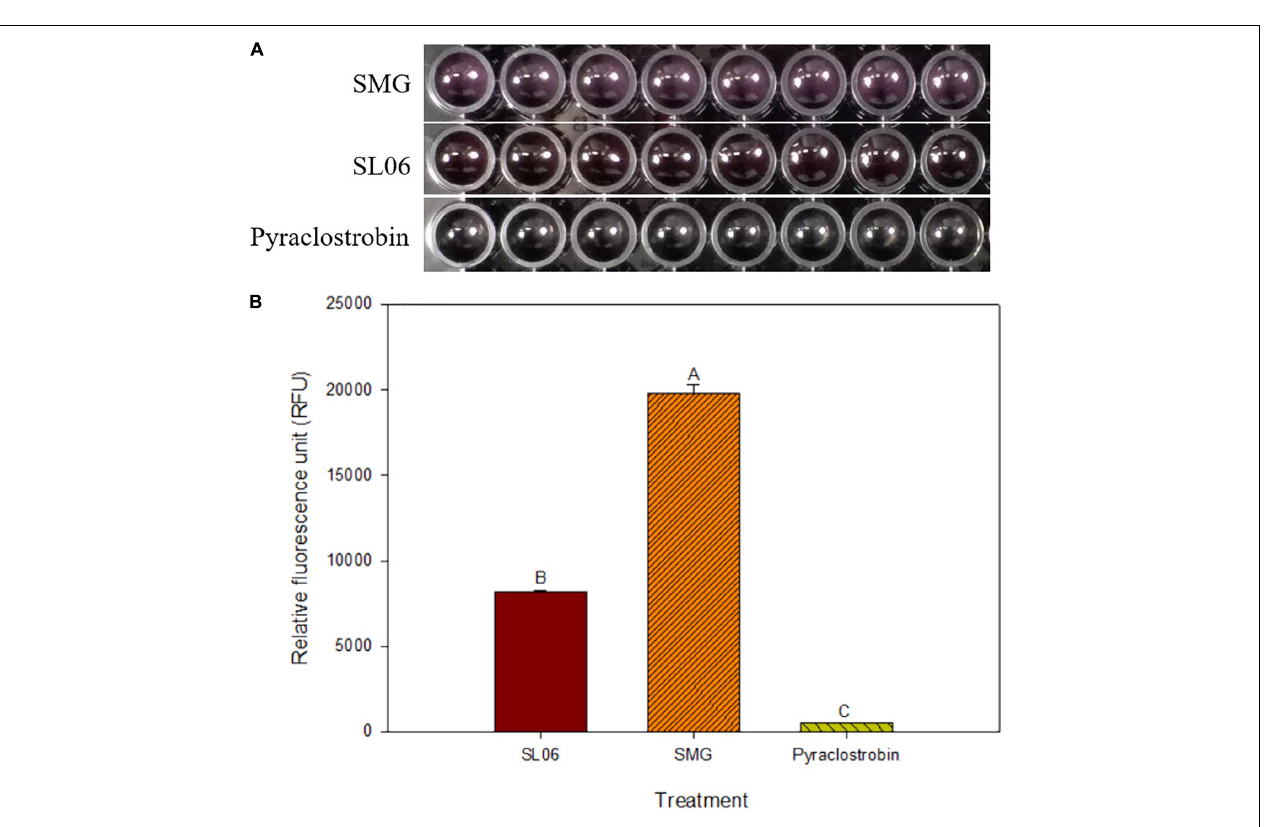
FIGURE 6 | Effect of Streptomyces griseorubiginosus LJS06 culture filtrate (SL06) on the energy metabolism of Colletotrichum orbiculare COC3. (A) Alamar blue turned pink in soybean meal broth-treated conidial suspension but remained unchanged in SL06-treated and pyraclostrobin-treated conidial suspensions after 24 h. (B) SMG-treated conidial suspension had significantly higher relative fluorescence units than SL06 and pyraclostrobin treatments, suggesting that the energy metabolism was impaired in the latter treatments. Means ( n = 8) followed by different letters are significantly different ( p < 0.05) according to Fisher’s least significant difference test. Bar = standard